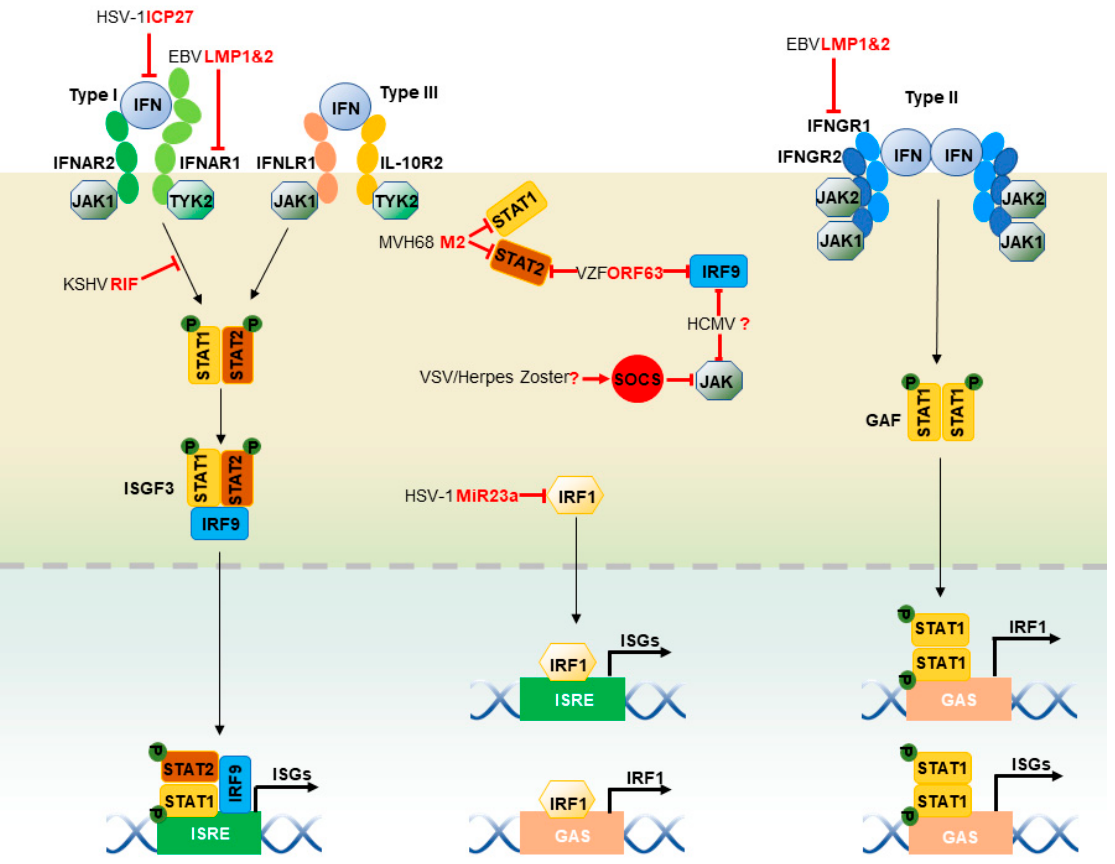
Figure 2. Herpesviruses modulate the JAK-STAT pathway. When IFNs are induced, Type I, II and III IFNs bind to their cognate receptor complexes. When bound to type I IFNs, IFNAR1 and IFNAR2 heterodimers recruit JAK1 and TYK2 to their cytoplasmic tails. Type III IFNs bind to IL-10R2 and IFNLR1 heterodimers to recruit JAK1 and TYK2. JAK1 and TYK2 are placed in proximity to IFN receptors and autophosphorylate to promote their activation. Activated JAK1 and TYK2 phosphorylate tyrosine residues within the intracellular carboxyl termini of STAT1 and STAT2. These phosphorylated STAT1 and STAT2 form a heterodimer that binds to IRF9, constituting the ISGF3 complex. In contrast, type II IFNs activate JAK1 and JAK2 by IFNGR1 and IFNGR2 heterodimers, leading to the phosphorylation of both JAK1 and JAK2, and the subsequent phosphorylation of receptor chains. Phosphorylated STAT1 forms a homodimer, known as GAF, and translocates into the nucleus. In addition, IRF1 can directly translocate into the nucleus and transactivate ISGs, including itself. The red lines delineate the impact of viral infection on the JAK-STAT pathway. Multiple steps of the JAK-STAT pathway are inhibited or hijacked by herpesviruses. The blind-ended lines and arrows indicate the cellular components that are inhibited and hijacked by herpesviruses, respectively. The question mark denotes an unknown herpesviral protein.